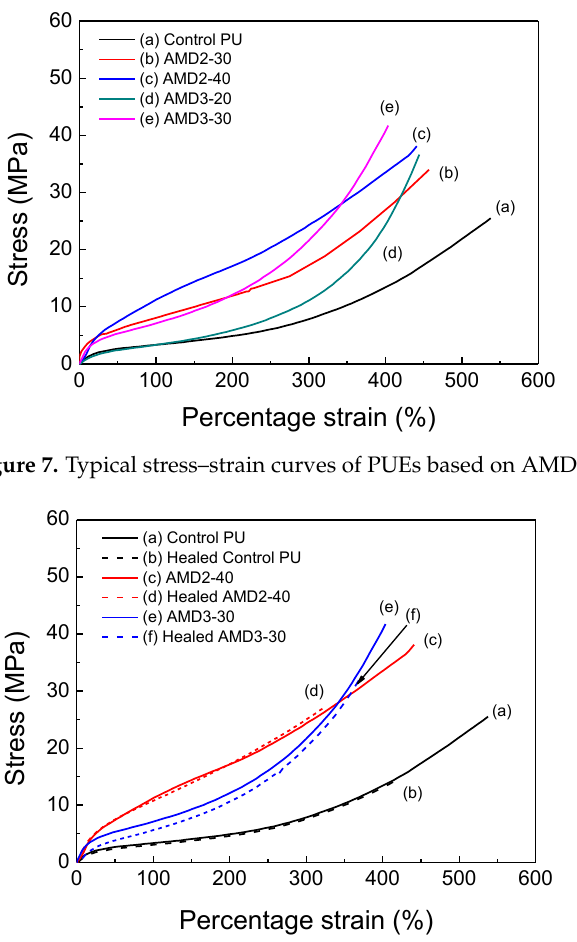
Figure 8. Stress–strain curves for AMD-based PUEs before (solid line) and after healing (broken line).